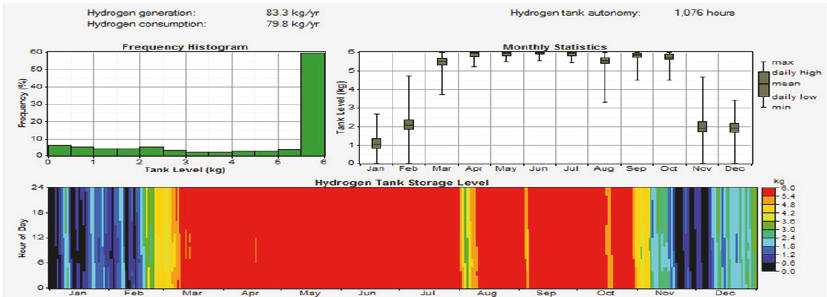
Figure 3: Simulation results from HOMER software for the hydrogen tank.